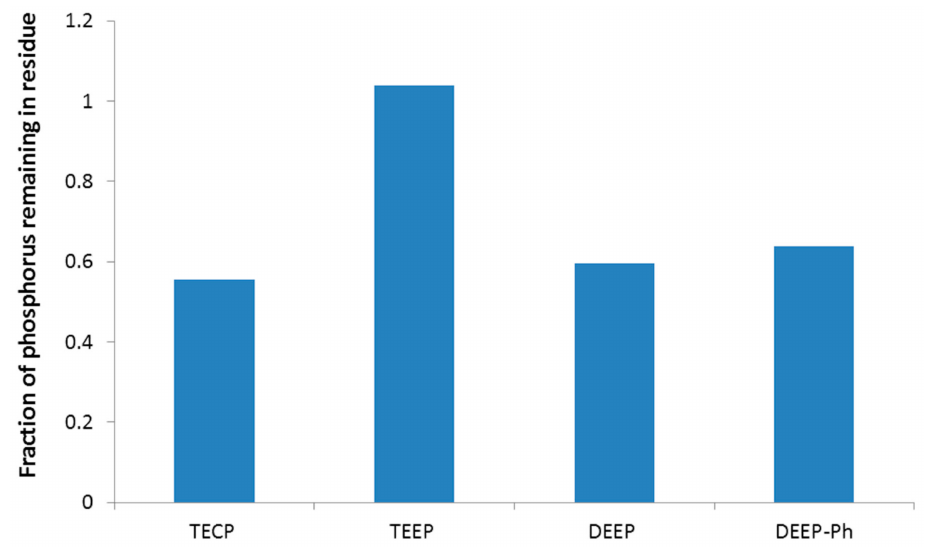
Figure 10. Fraction of phosphorus remaining in